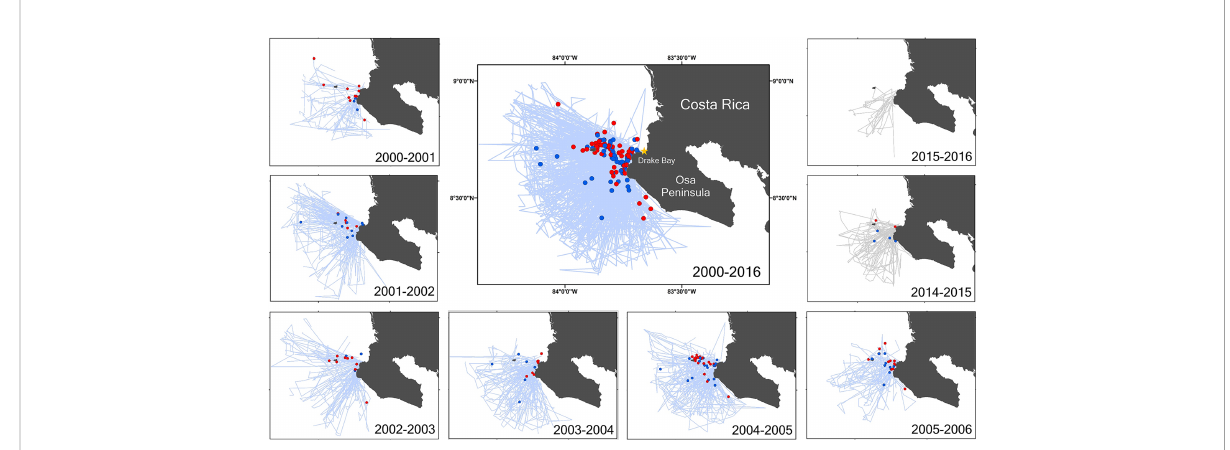
FIGURE 1 Breeding grounds of the Northeast Paci fi c humpback whales in Osa Peninsula, Costa Rica. Effort (blue lines); Adult humpback whale sightings (blue dots); Mother-calf pairs sightings (red dots). The port of departure and landfall was at Drake Bay, Osa